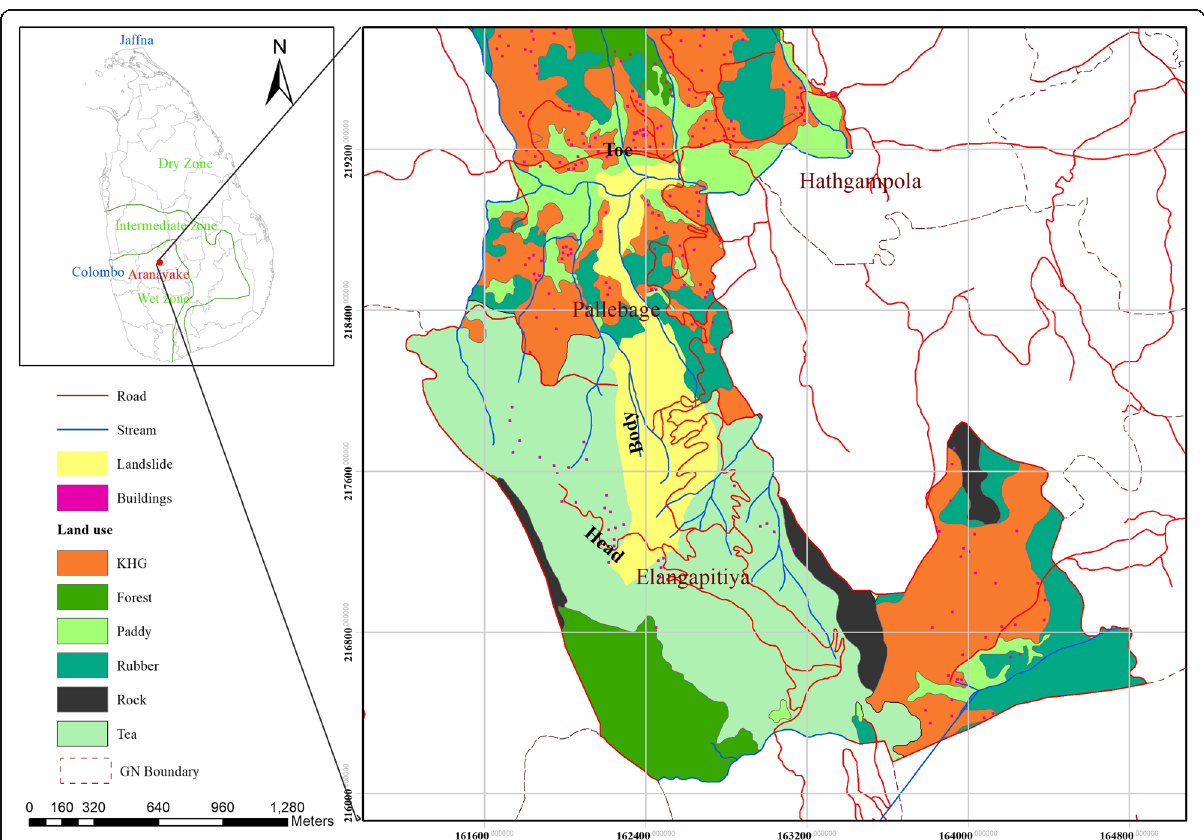
Fig. 1 Figure showing land-use of Landslide affected GN divisions; Debathgama, Pallebage, and Elangapitiya. Land use based on 1:50000